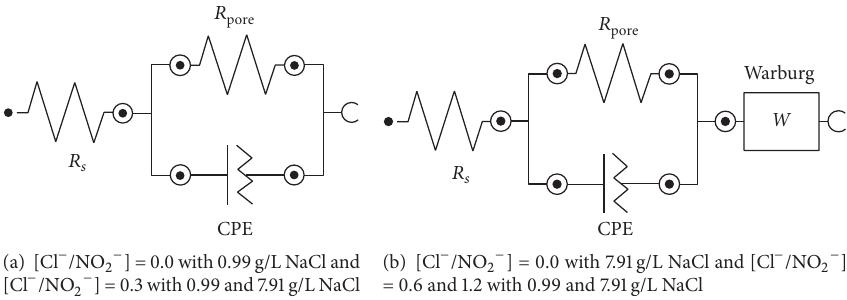
Figure 7: Electrical equivalent circuit (ECC) with different concentrations of NaCl and [Cl − /NO 2− ] in saturated Ca(OH) 2 solution. Table 3: Electrochemical parameters extracted after fitting of EIS plots in suitable EEC of steel rebar exposed in solutions. Concentration [Cl − /NO 2− ] of NaCl (g/L) 0.0